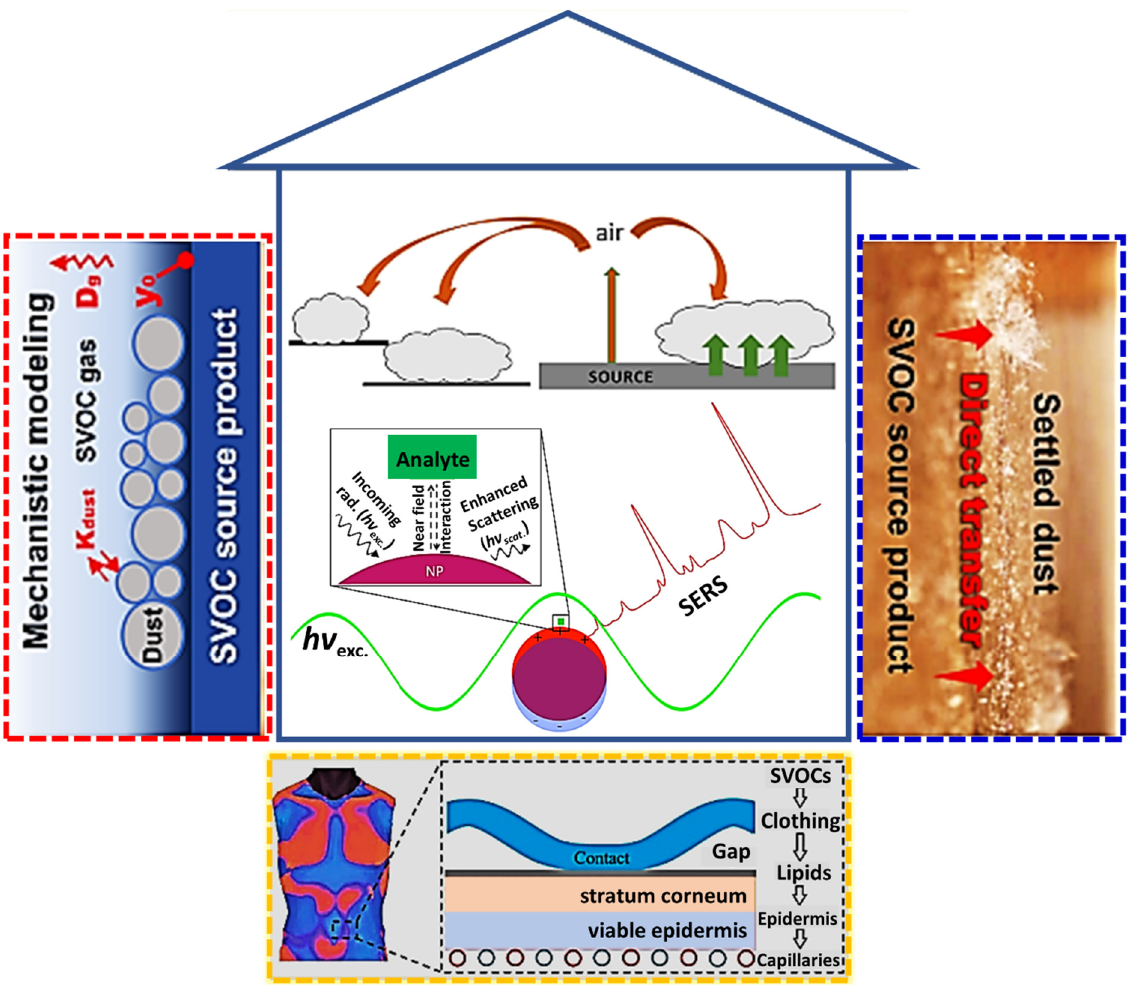
Figure 1. Applications of plasmonic resonance-based SERS sensors for on-site detection of indoor SVOCs. Adapted from [9,18,22,32].